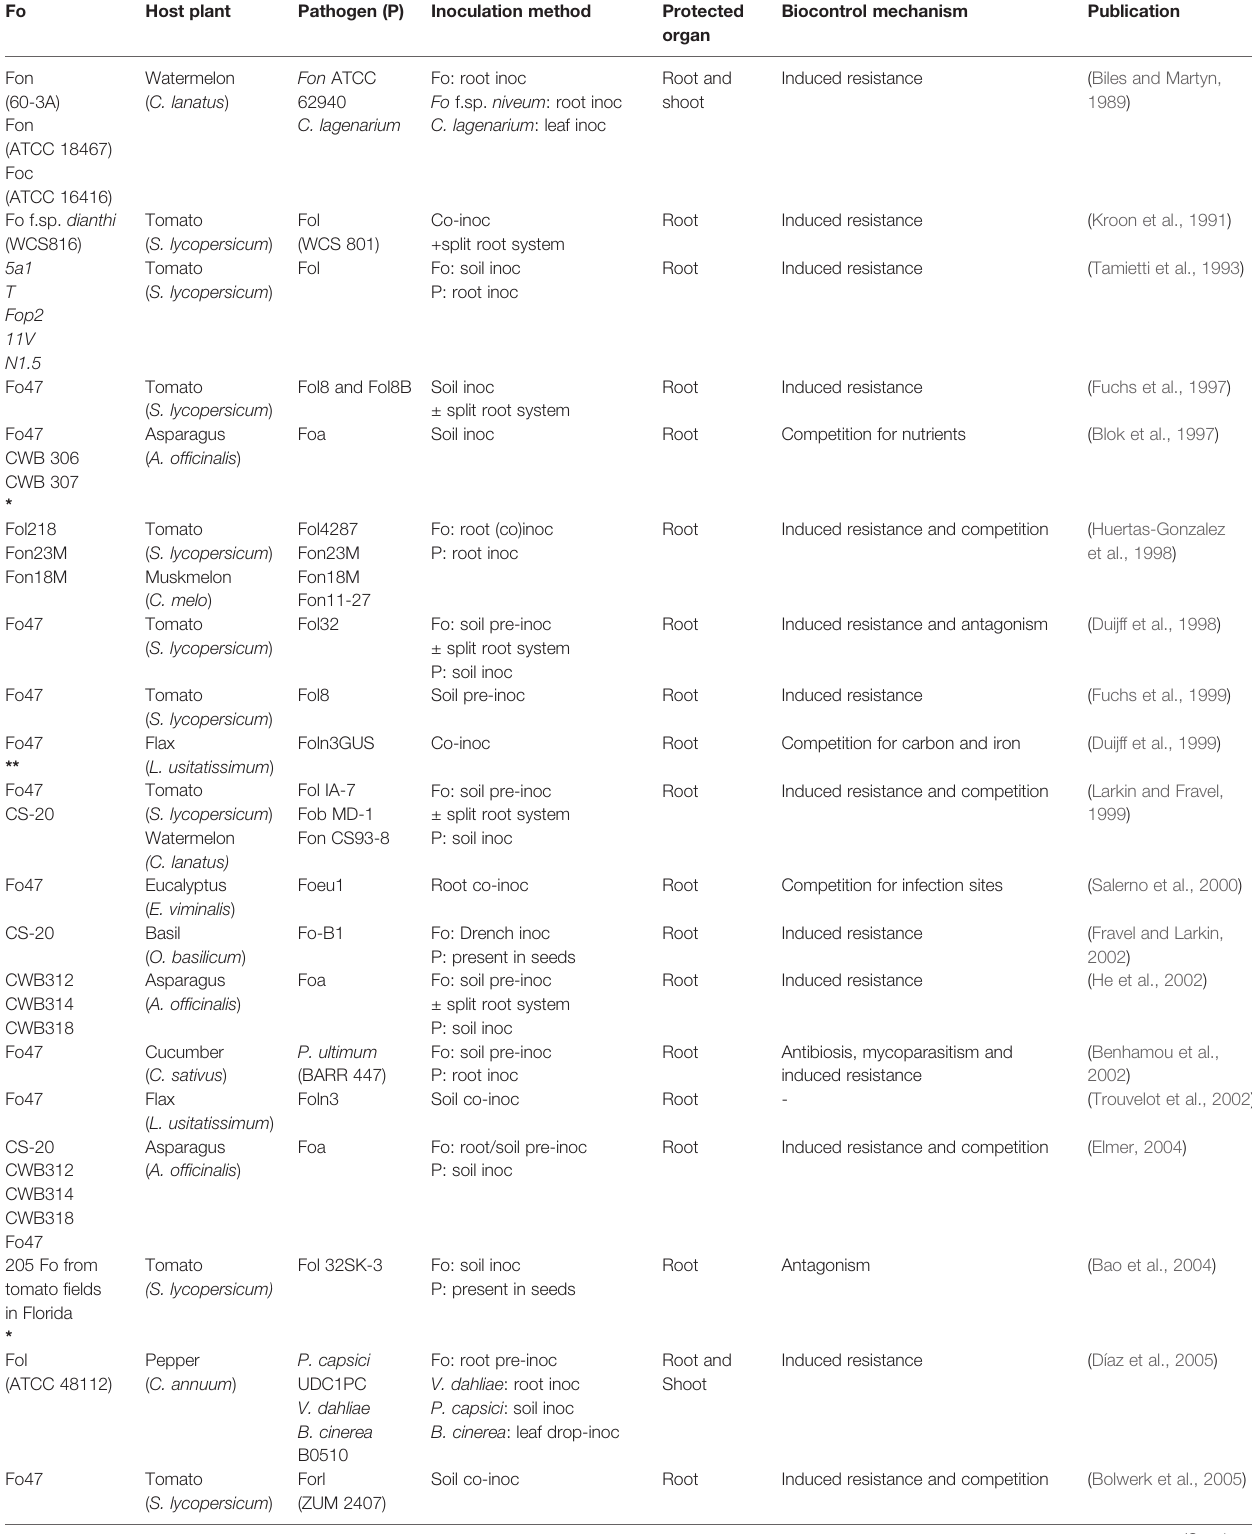
TABLE 1 | Fusarium oxysporum (Fo)-mediated biocontrol in various plant species.